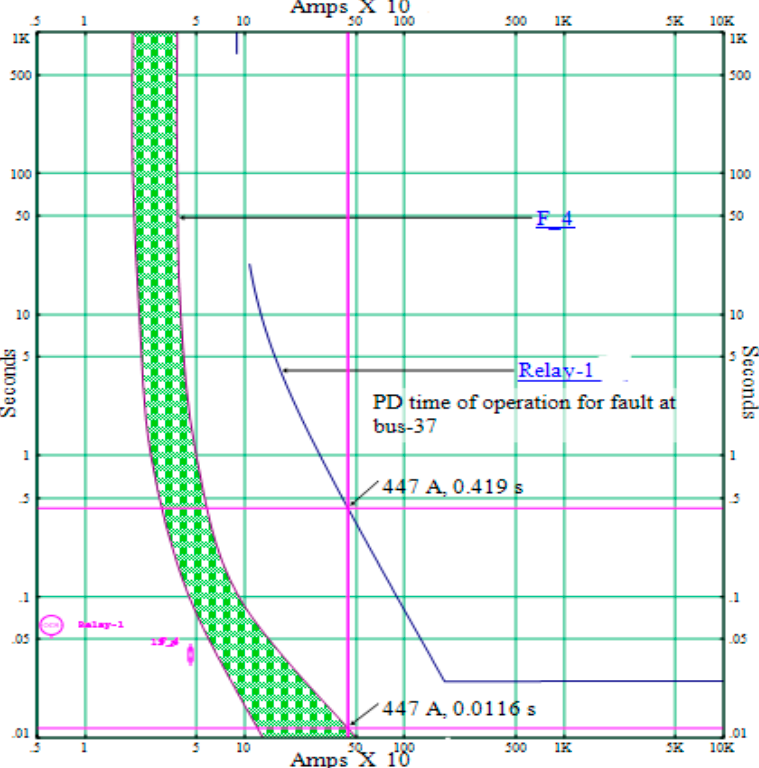
Figure 14. Log–log diagrams of the relay and downstream fuse 4.